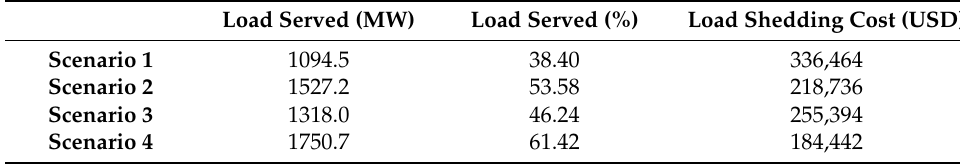
Table 16. Summary of costs.